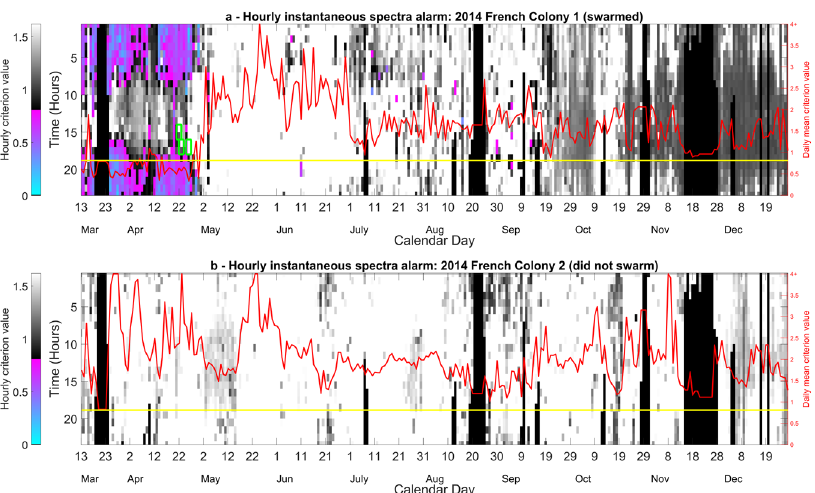
Figure 3. Time course of the swarming alert for a specific colony that ( a ) swarmed and ( b ) did not swarm, using the DF spectra in Fig. 2. The instantaneous alarm (computed without any contribution coming from past data) for these two colonies was monitored from the 13 th March until 1 st December 2014. The colour coding has been split to clearly convey two very different pieces of information. Greyscale tones correspond to the alarm values above the threshold (non-swarming state) and the remaining colour emphasises the alarm values below the threshold (swarming state), from pink to blue as the criterion approaches the swarming centroid. Green rectangles show the occurrence of three swarms within this dataset, with the earliest one being the primary swarm. Superimposed is another, red curve, with its own Y-axis shown on the extreme right, showing the average of the previous night’s alarm values taken between midnight and 5:00 AM. The yellow line displays the alarm threshold. Note that the black sections seen within the hourly alarm plots are the result of missing data, due to power cuts. This figure was created using the MATLAB (R2018b) software